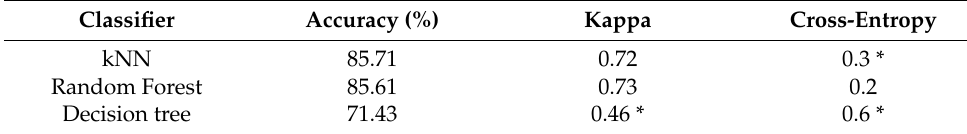
Table 3. The comparison results of the tested classifiers.